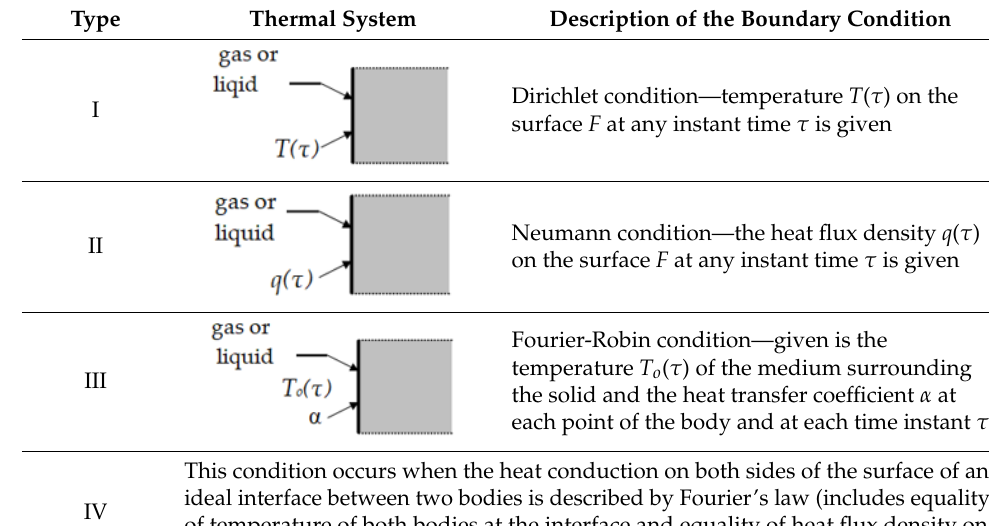
Table 1. Boundary conditions in thermal systems.